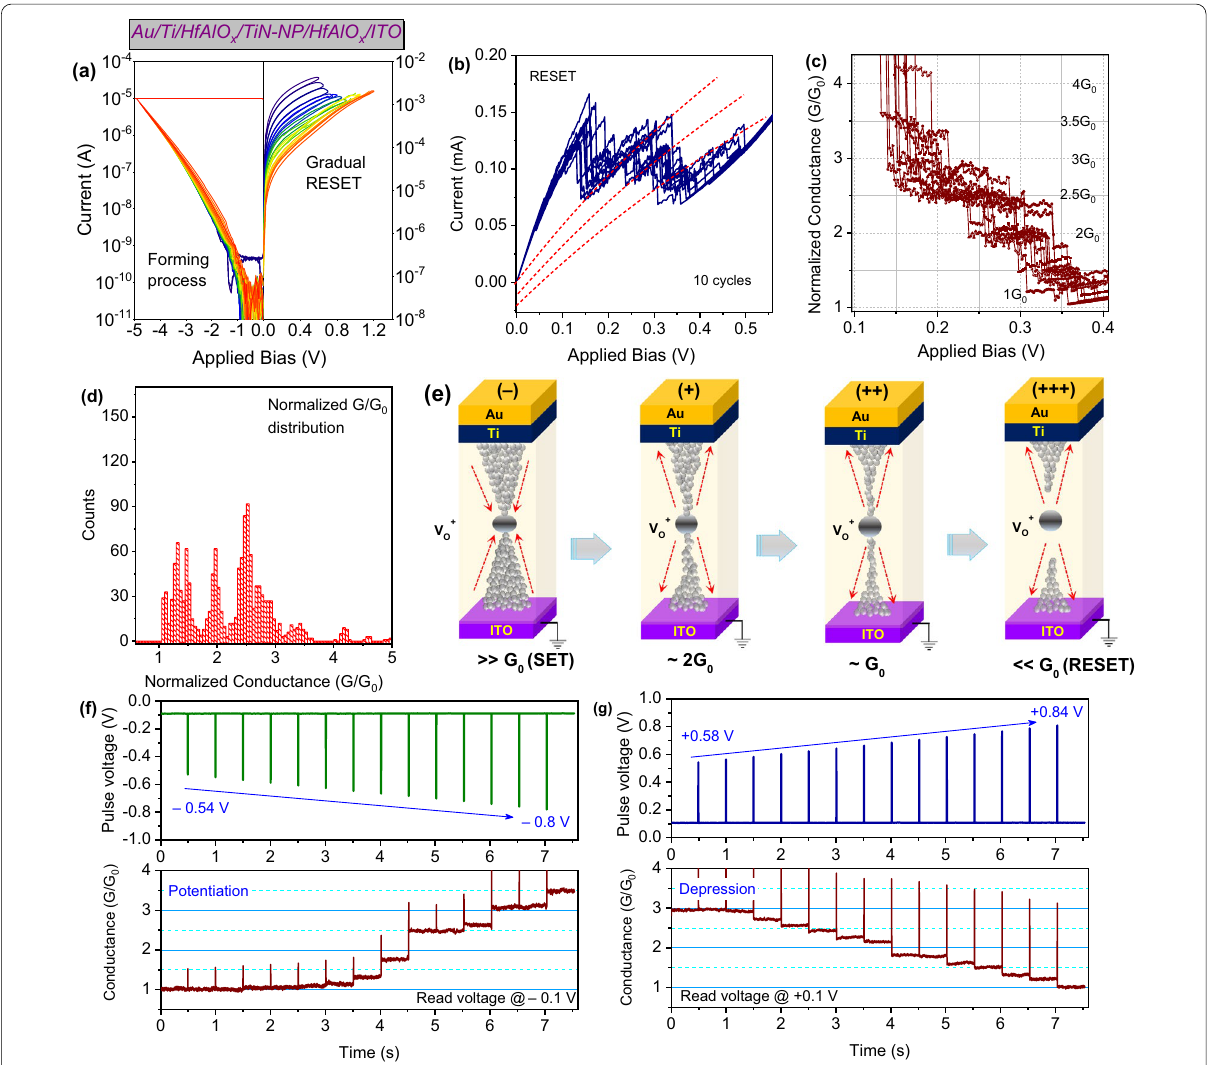
Fig. 3 a Gradual electroforming and RESET process with stepwise increment of applied bias at both polarities shows multilevel memory properties. b Quantized conductance properties of TiN-NP-based RRAM device by I ‒ V characteristics during DC voltage sweep RESET characteristics. c Corresponding Normalized conductance (G/G 0 ) vs voltage curves from multiple cycles. d Histogram obtained from the G/G 0 collected from multiple cycles. e Schematics of the narrowing in conductive filaments during progressively increasing of RESET voltage. f , g Increasing and decreasing of quantized conductance with negative pulse from ‒ 0.54 V/1 ms to ‒ 0.0.8 V/1 ms, and positive pulse from to 0.84 V/1 +